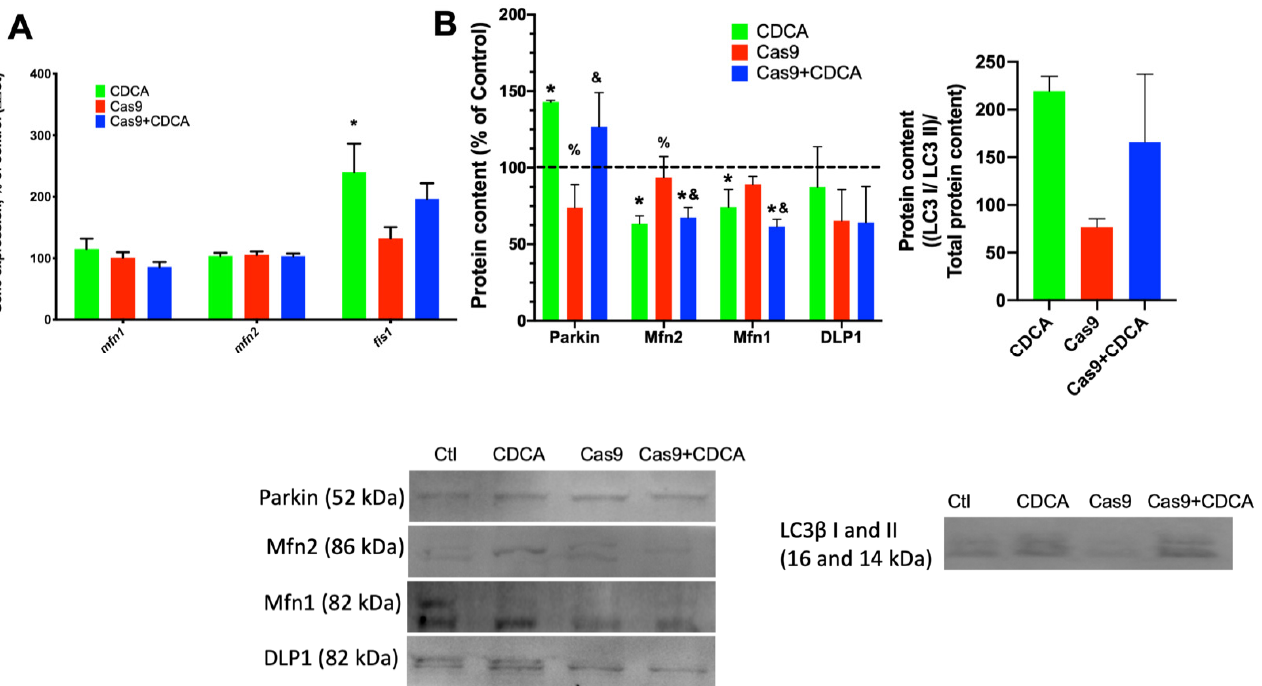
Figure 5. Mitophagy evaluation on 3T3-L1 adipocytes exposed to CDCA in the absence or presence of TGR5. ( A ) Gene expression of mitodynamics-involved proteins mitofusins 1 and 2 ( mfn1 and mfn2 ) and fission protein 1 ( fis1 ); ( B ) Protein content of several players involved in mitophagy and mitochondrial fission and fusion. DLP1—Dynamin-like protein 1; Mfn1—Mitofusin 1; LC3—Light chain 3B; Mfn2—Mitofusin 2. Data are derived from 3 independent experiments, and bars represent means ± SEM. * indicates a statistically significant difference vs. Control ( p < 0.05); % indicates a statistically significant difference vs. CDCA ( p < 0.05); & indicates a statistically significant difference vs. Cas9 ( p < 0.05).